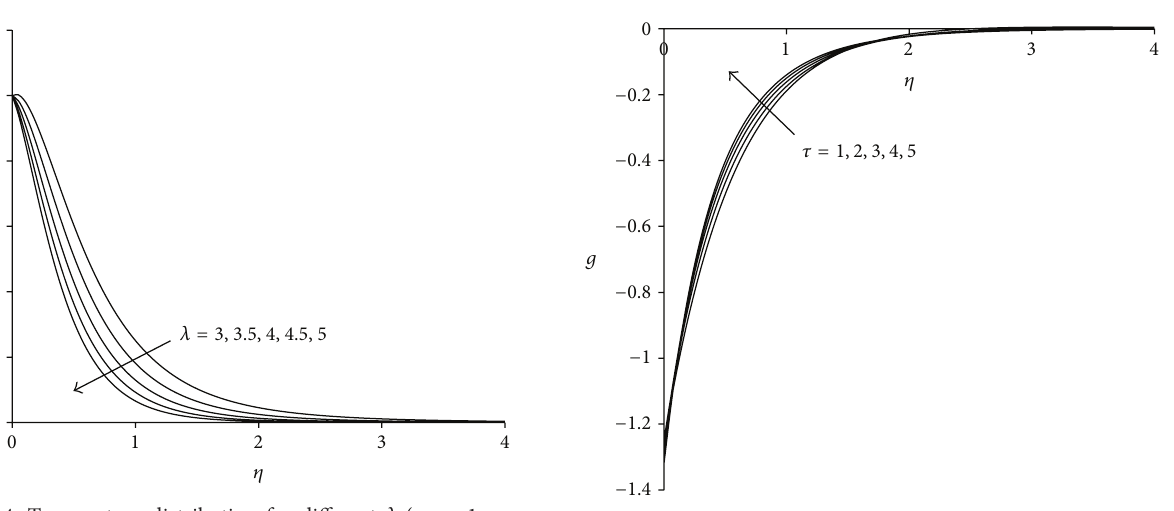
Figure 6: Microrotation distribution for different 𝜏 (𝜆 = 3, 𝜎 = 3, Ec = 0.75) .